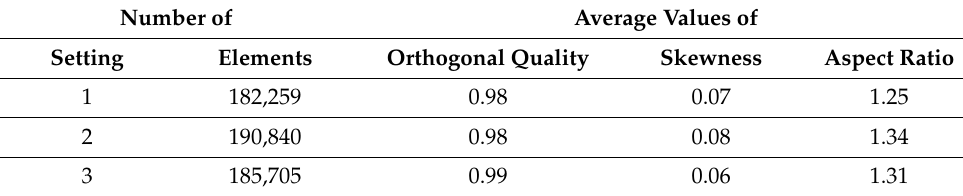
Figure 2. The meshes of the observed models. Table 2. The mesh